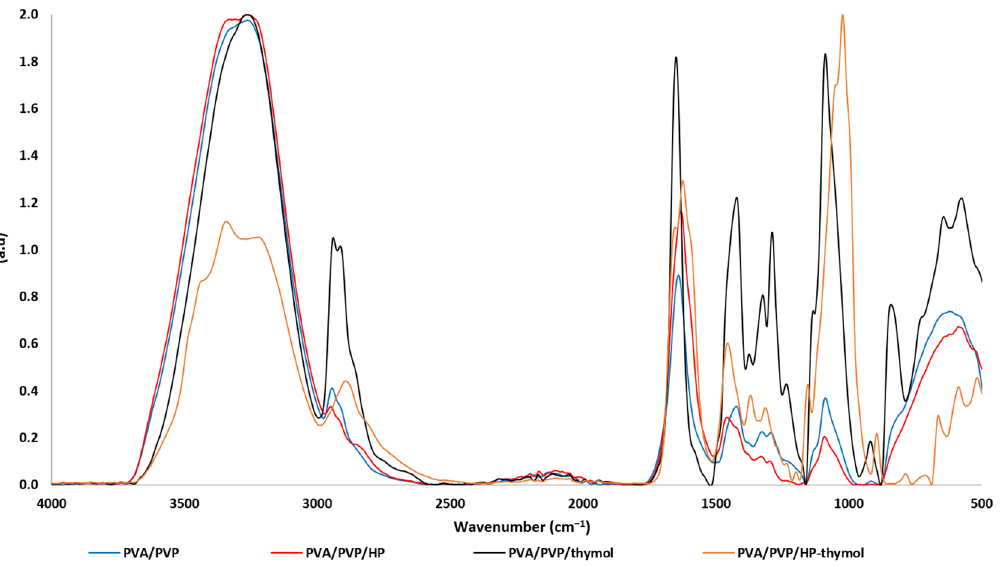
Figure 3. FTIR/ATR spectra of plain (blue), HP-loaded (red), thymol-loaded (black) and HP and thymol-loaded (orange) PVA/PVP hydrogels.